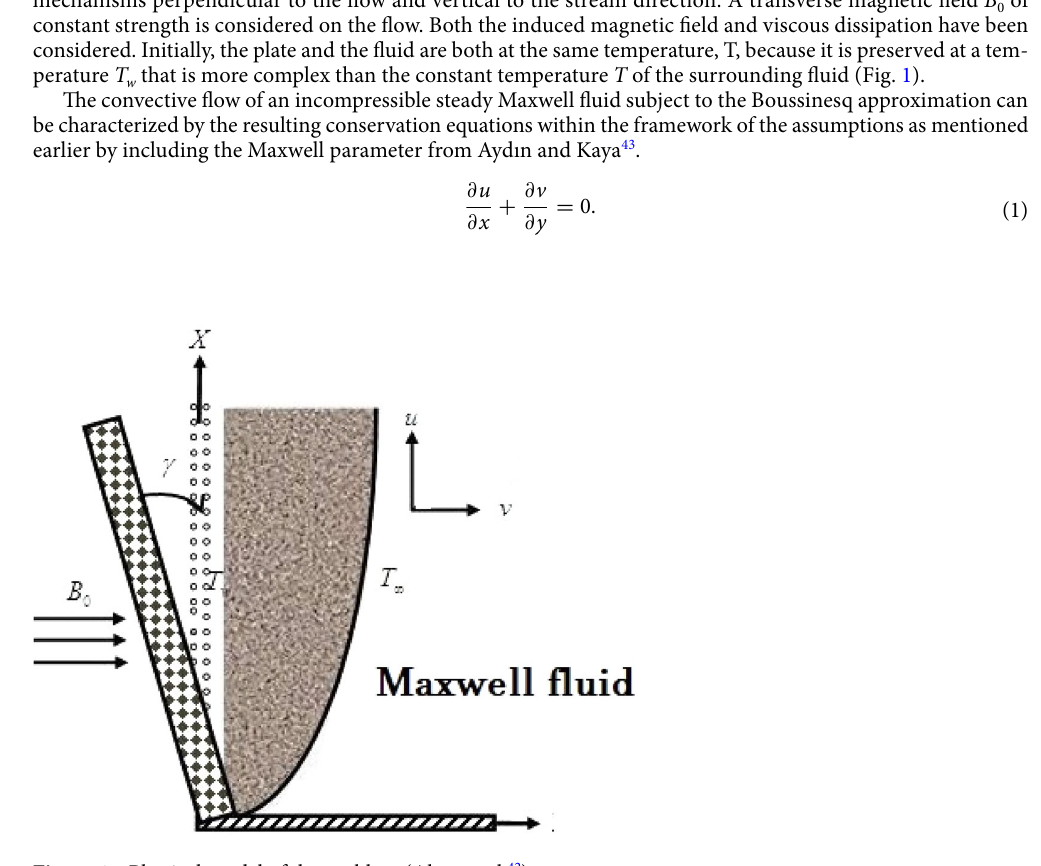
Figure 1. Physical model of the problem (Alam et al. 42